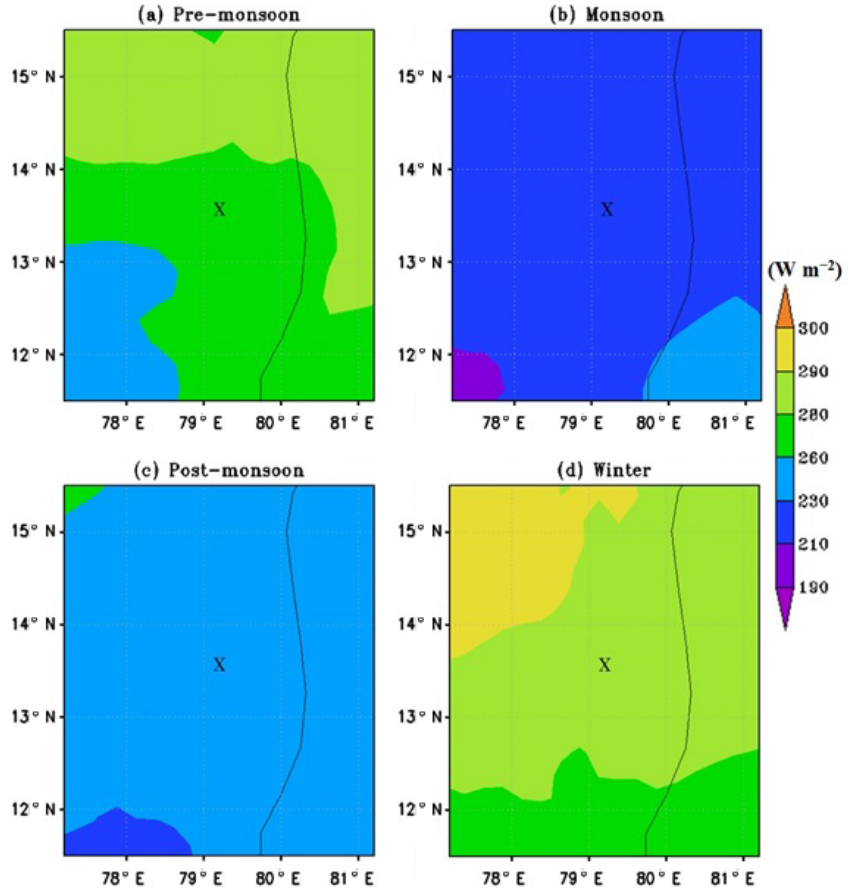
Figure 3. Seasonal mean distribution of OLR around the Gadanki location observed during (a) pre-monsoon, (b) monsoon, (c) post-monsoon, and (d) winter seasons averaged during 2006–2017. The symbol “X” indicates the location of